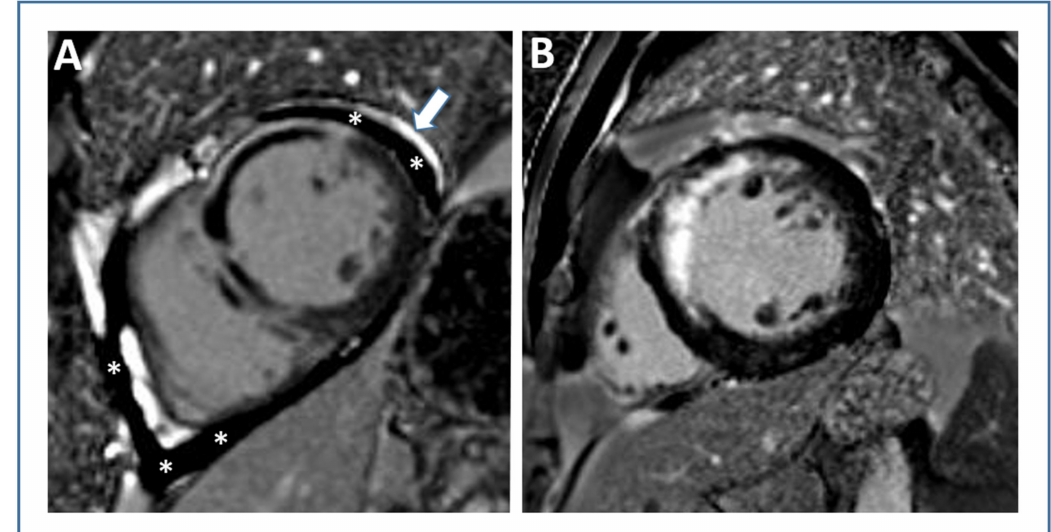
Figure 6. Pericardial injury due to acute STEMI. Late gadolinium-enhanced images of two patients with anterior wall STEMI: “Patient A” shows pericardial injury (pericardial e ff usion indicated by white stars, pericardial enhancement indicated by the white arrow, ( A )), while no signs of pericardial injury are present in “Patient B” ( B ). Abbreviations: STEMI, ST-elevation myocardial